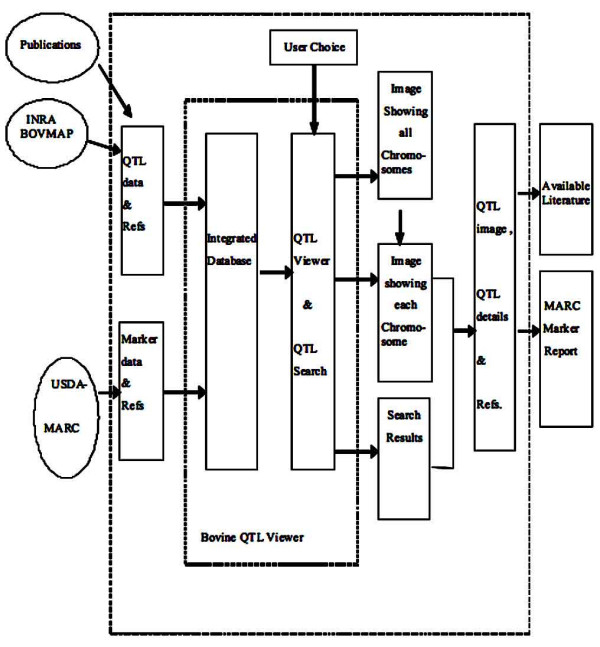
QTL viewer description. This is a diagrammatic view describing the inputs and outputs from the database and viewer. QTL and marker information are assembled from the literature or web sites and entered into the linked, discrete marker and QTL databases. The integrated marker/QTL database serves as the back end for queries emanating from the user interface (viewer). The viewer will display different views depending on user choices which can ultimately be resolved to single QTL details with links to literature and markers.